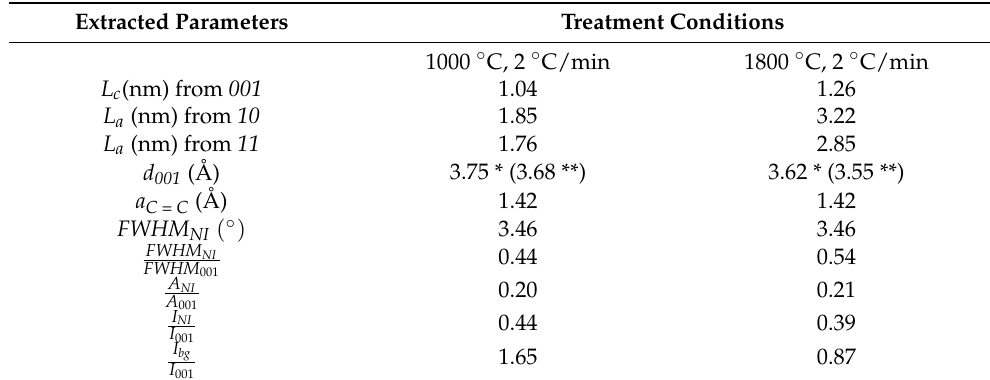
Table 3. XRD parameters for cellulose-derived carbons at different carbonization temperatures. * From the Bragg’s law without correction, corresponding to the apparent intergraphene spacing, ** with correction corresponding to the true intergraphene spacing (see [10]).